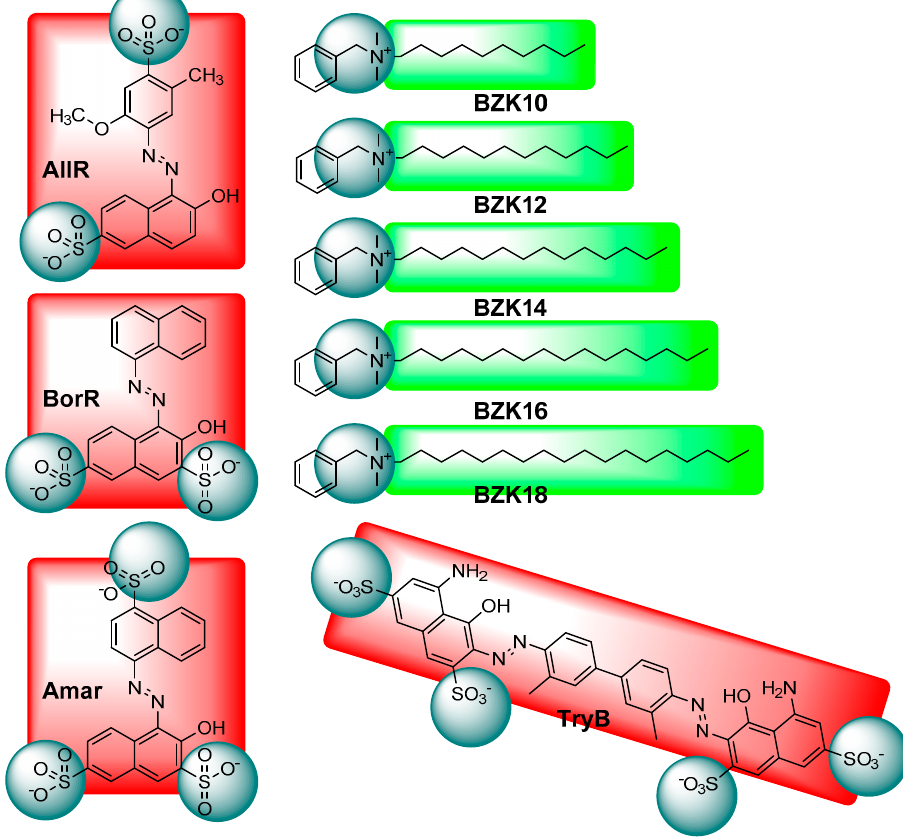
Figure 1. Functional units (red): Allura Red AllR , Bordeaux red BorR , Amaranth Amar , and Trypan Blue TryB ; and benzalkonium surfactants BZK (green) used to make ionic self-assembled materials, the ionic groups are indicated in gray. All combinations of BZK and AllR , and BorR , and Amar were